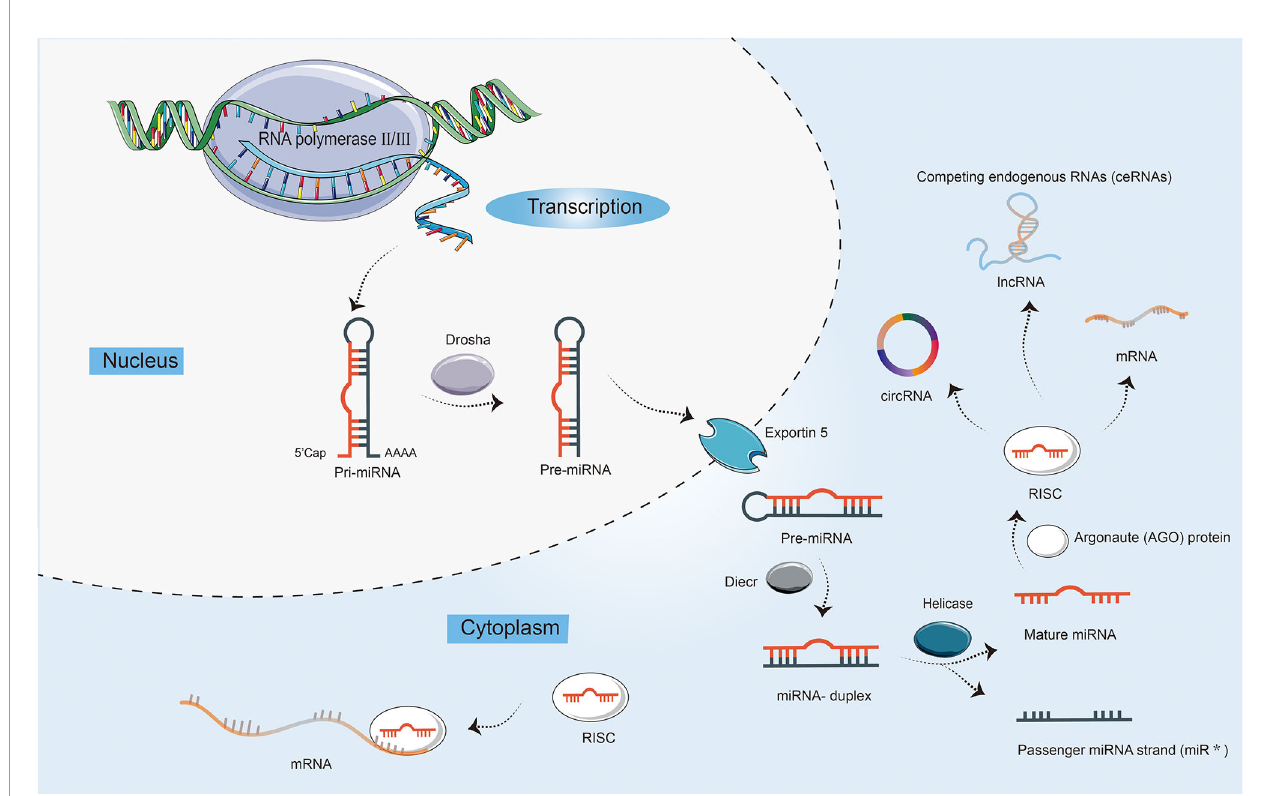
FIGURE 1 | The biogenesis and characteristics of microRNAs (miRNAs). First, the transcription of a primary miRNA transcript (pri-miRNA) by RNA polymerases II and III. Second, the production of pri-miRNA by the nuclear ribonuclease Drosha into a precursor miRNA (pre-miRNA) with a stem-loop structure. Third, nuclear export of pre- miRNAs by exportin 5. Fourth, the cleavage of pre-miRNAs by enzyme Dicer to yield double-stranded miRNA and its helicase-mediated unwinding. Finally, the passenger strand is degraded, while the mature miRNA strand is integrated into Argonaute (AGO) protein in the RNA-induced silencing complex (RISC). miRNAs not only can mediate translational repression by interacting with mRNAs, but also target long ncRNAs (lncRNAs) and circular RNAs (circRNAs). In addition, competing endogenous RNAs (ceRNAs) can regulate other RNA transcripts by competing for shared